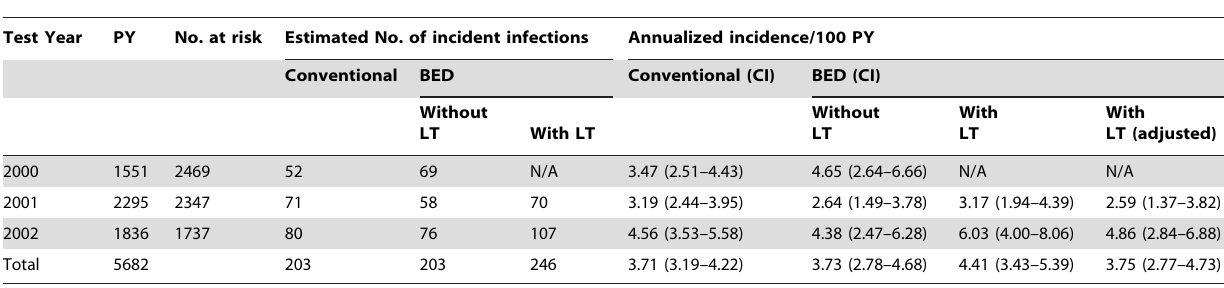
Table 2. Comparison of conventionally and BED-estimated incidence: effect of long term infections.